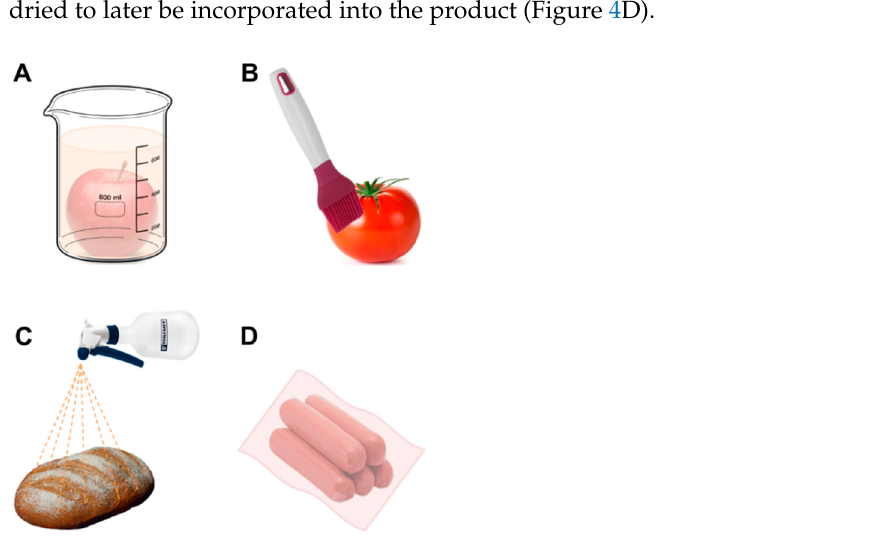
Figure 4. Main techniques used for food coating. ( A ) Dipped; ( B ) Spread; ( C ) Sprayed; ( D ) Wrapped.